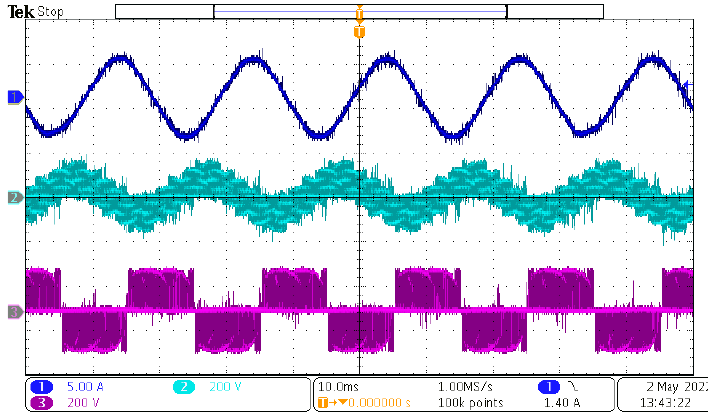
Figure 14. Waveforms at the output of the 3 × 5 matrix converter (output phase current—blue, phase to neutral voltage—cyan, phase to phase voltage—purple).